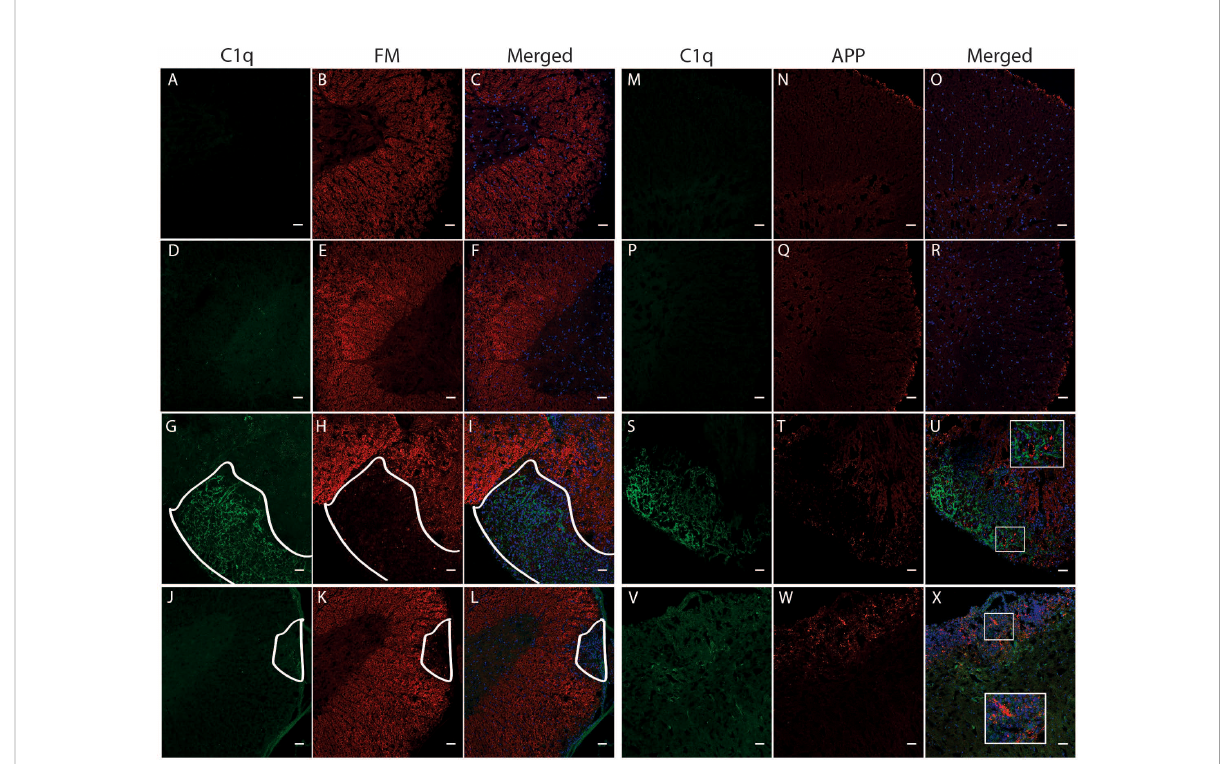
FIGURE 8 Colocalization of C1q, fl uoromyelin and APP in the spinal cord of TMEV-IDD and rEAE mice. TMEV-IDD and rEAE mice were necropsied at ~120 dpi (chronic stage) and ~15 dpimm (acute relapse), respectively. Spinal cords were harvested for immunohistochemical analyses of the complement component C1q (A, M, D, P, G, S, J, V) , the myelin marker fl uoromyelin red (B, E, H, K) and the axonal damage marker APP (N, Q, T, W) . Age-matched sham controls show no apparent C1q staining (A, D, M, P) , as well as no demyelination (B, E) or APP deposits (N, Q) . In TMEV-IDD, C1q staining (green in G, S) is observed in regions lacking fl uoromyelin staining (red in I), i.e., demyelination and areas enriched of APP deposits (red in U), con fi rming an association between the activation of the classical pathway and CNS damage. In contrast, in rEAE, we found that C1q (green in J, V) does not colocalize with either demyelination (red in L) or axonal damage (red in X), suggesting that, in these mice, the activation of the classical pathway is not directly involved in CNS injury. Merge of C1q and fl uoromyelin (C, F, I, L) and C1q and APP (O, R, U, X) is shown with DAPI (blue) for clarity of nucleus localization. Insets in images show white boxed areas at higher magni fi cation. In (G – L) , areas of demyelination are demarcated by a solid white line. Images are representative of 4 to 5 mice per group. Representative z stacks are shown and the scale bar = 100 m